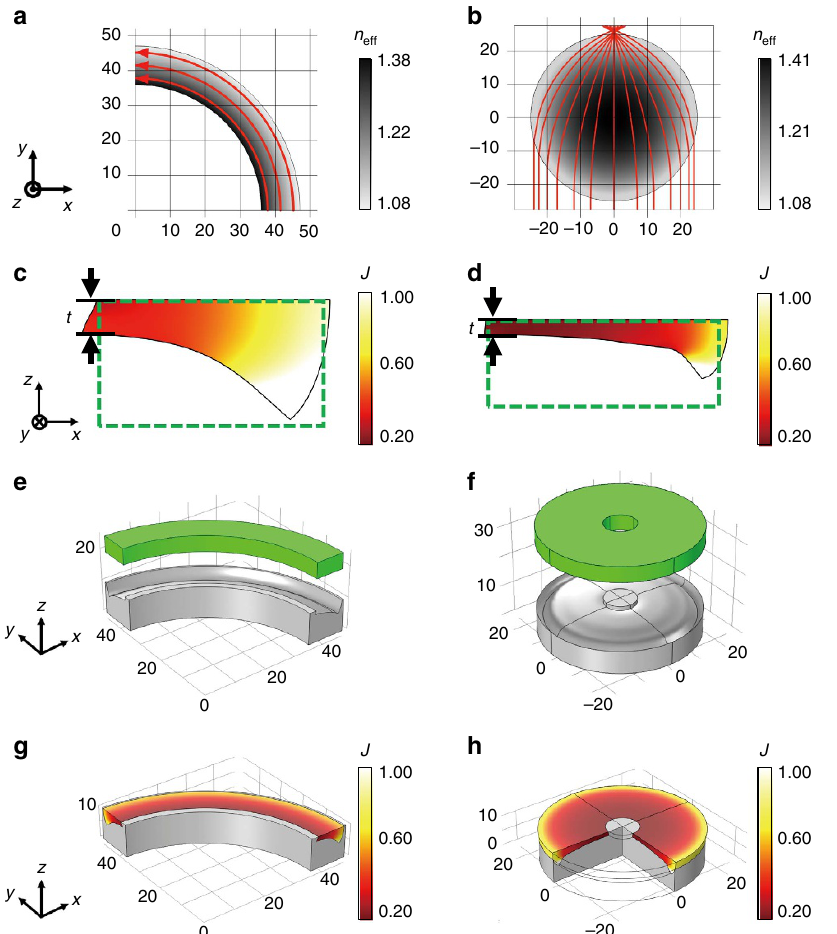
Figure 3 | Design and pressing process of a wave bender and a Luneburg lens. ( a , b ) COMSOL simulation results of propagating rays on a transformation- optics (TO) wave bender (a) and an optical Luneburg lens (b). 2D refractive-index distributions (grey scale) of a TO wave bender and an optical Luneburg lens ffiffiffiffiffiffiffiffiffiffiffiffiffiffiffiffiffiffiffiffi (cid:5) (cid:6) 2 r and n eff ¼ 2 (cid:3) r , respectively, where R 0 is the outer radius, and r is the distance from the origin in the xy -plane. ( c , d ) Using the inverse are n eff ¼ R 0 r R 0 function of the effective index n eff ( J ) of compressible aerogels, we transformed the designed index distribution into the compression ratio distribution, J ( n eff ). Dashed lines indicate the cross-sections of the initial homogeneous aerogels. Solid lines show the cross-sectional shapes after compressing to obtain the designed compression ratio and effective index distributions on the top surface. These devices properly operate within the thickness t . ( e , f ) Designed pressing moulds (grey) and homogeneous aerogel bulks (green) for each device before elastic deformation. ( g , h ) Compression profiles in the TO wave bender and the optical Luneburg lens achieved by compressing homogeneous aerogels with pressing moulds in the z -direction. Appropriately deformed aerogel bulks have the desired compression ratio and index distributions. Thermal colour bars indicate the compression ratio ( c , d , g , h